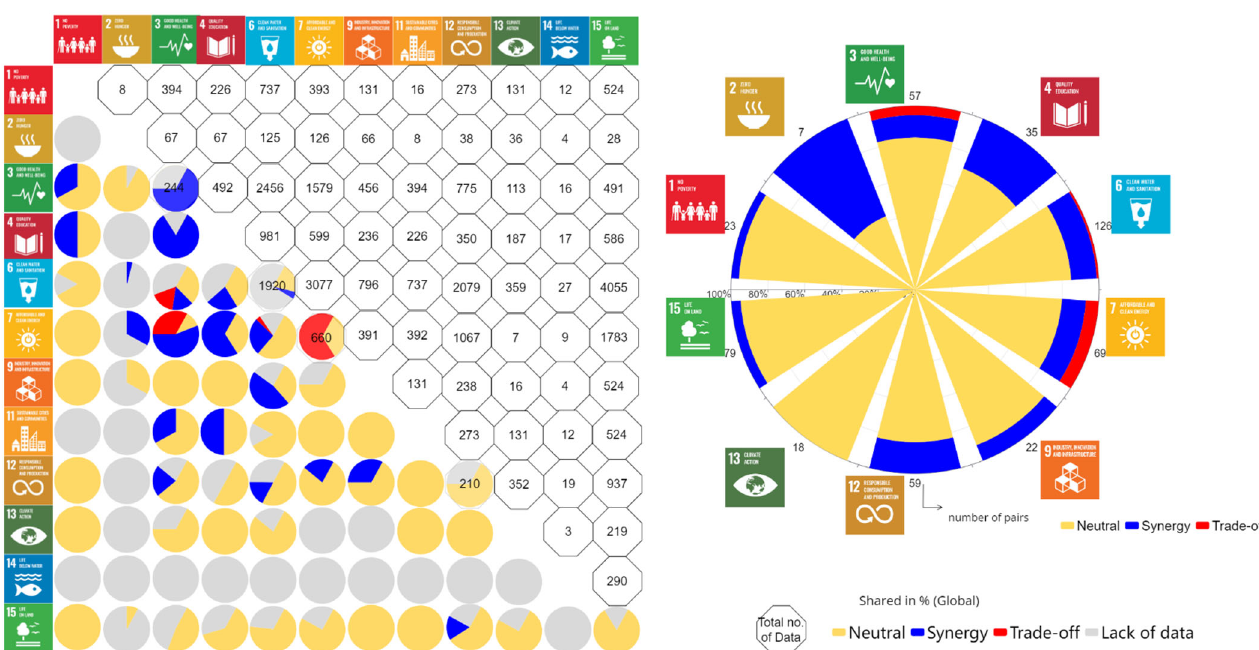
Figure 2. Matrix of interlinkage percentage with number of samples ( left ) and shares in percentage of global interlinkage with total number pairs ( right ).